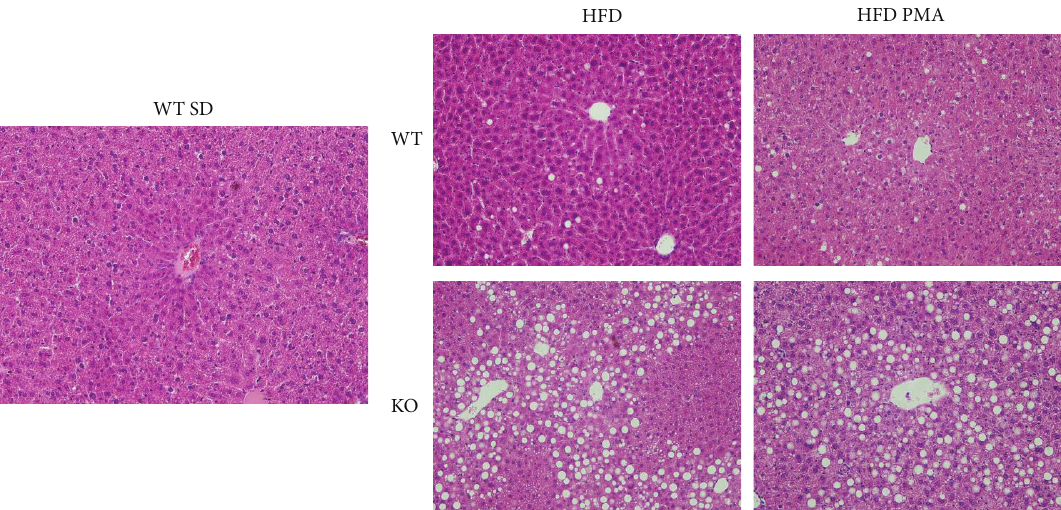
Figure 3: Histological slices of livers colored by hematoxylin and eosin (HE) at 40x magnification. Livers of WT mice fed with a standard diet (SD) or WT and PPAR 𝛼 -knockout (KO) mice submitted to a high fat diet and treated with oleic acid (HFD) or palmitoleic acid (HFD